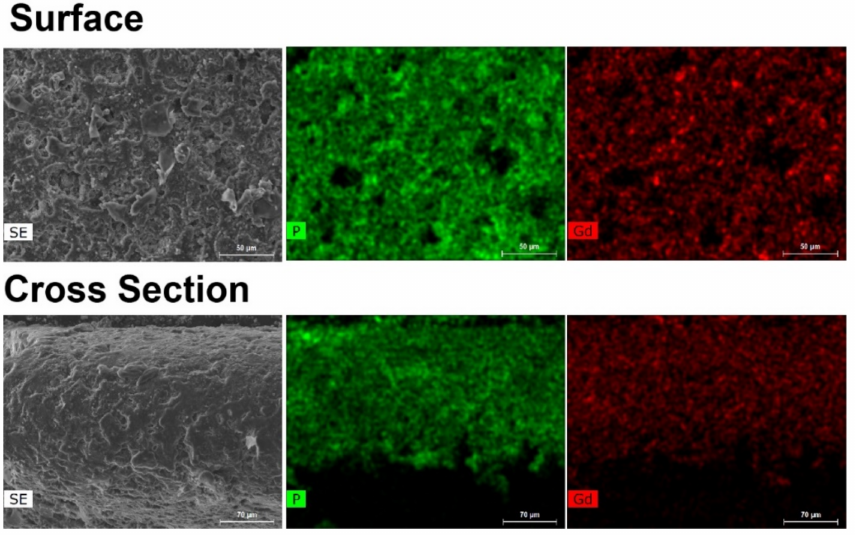
Figure 11. EDS mapping of UAV-59@PMMA at the membrane surface and a cross section after the catalytic